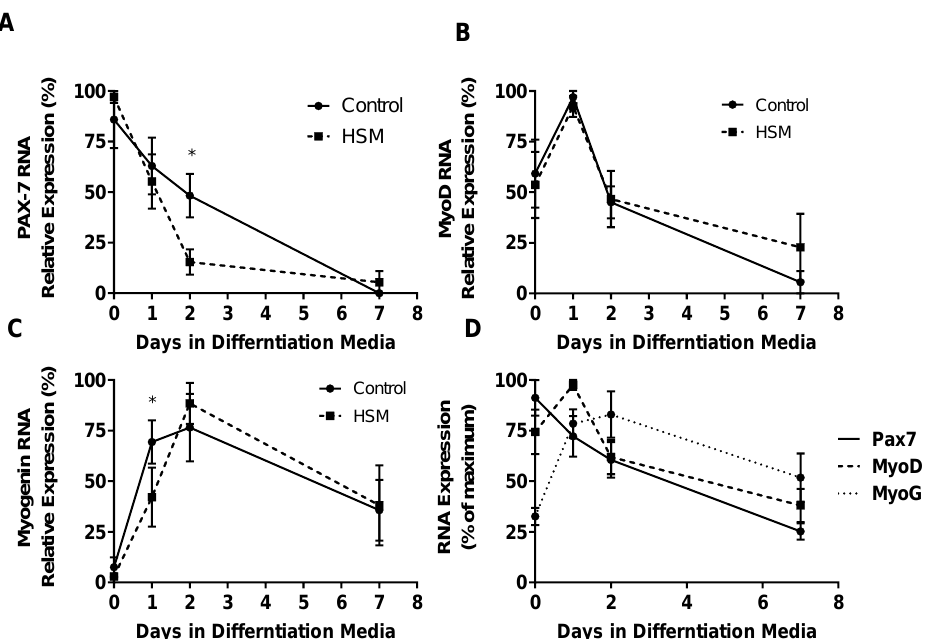
Figure 7. E ff ect of exposure to control or high substrate media (HSM, + 400 mM, 2:1, oleate–palmitate, + 20 mM glucose) on sedentary lean (SedLn) satellite cells (SCs) ( n = 6) expression of myogenic factors; PAX-7 ( A ), MyoD ( B ), and MyoG ( C ), after 0, 1, 2, and 7 days of di ff erentiation. Overlaid expression of PAX-7, MyoD, and MyoG throughout di ff erentiation of control treated SC from SedLn donors ( D ). (*, **, *** indicating a p -value of <0.05, <0.01, <0.001, respectively).